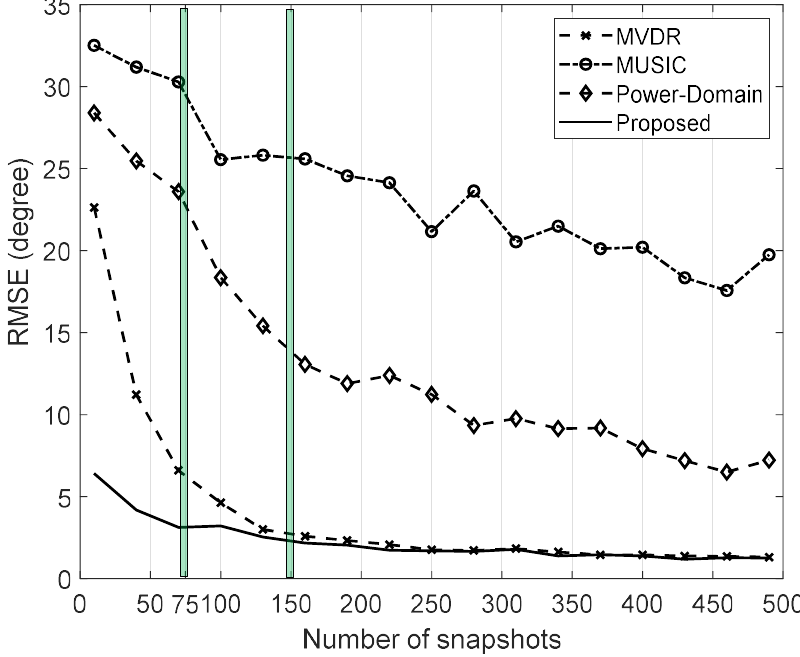
Figure 2. Root-mean-squared error (RMSE) versus the snapshot for the different estimators (MUSIC, MVDR, Power-Domain, and the proposed estimator) for Example 1.